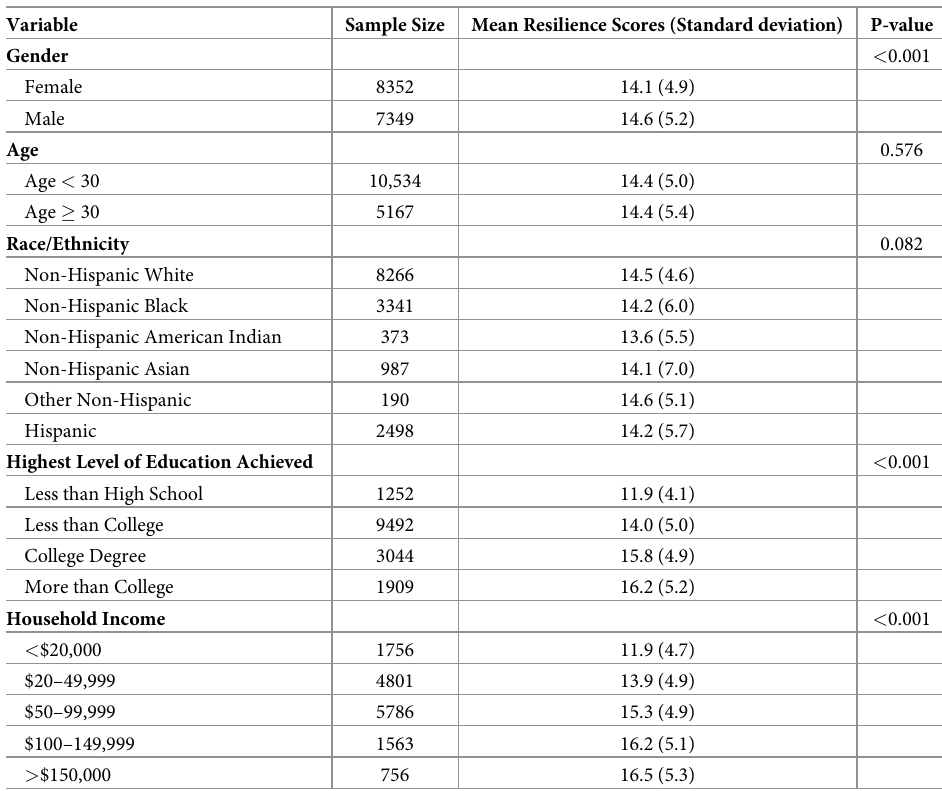
Table 4. Differences in mean resilience scores by demographics.